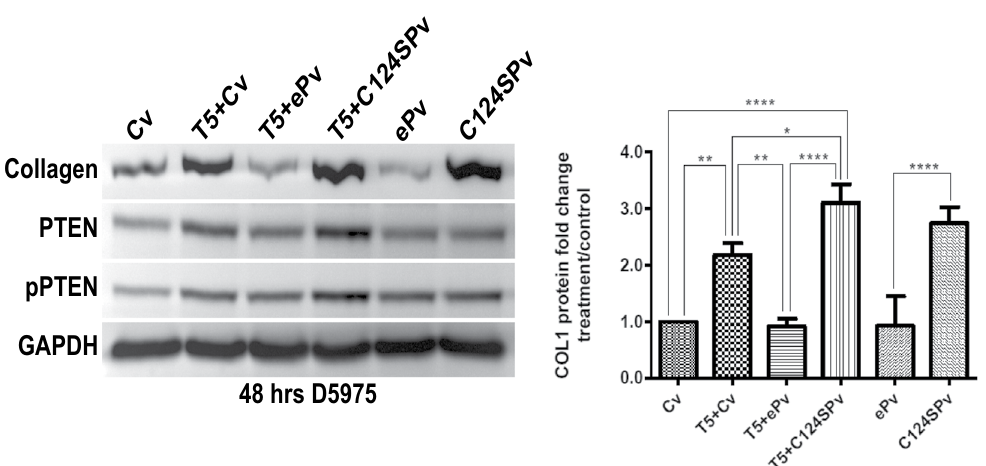
Figure 5. PTEN activity modulates collagen expression in human TM cells. TM cells were treated with TGF- β 2 (5 ng/ml) and transfected with control GFP-vector (Cv), enhanced PTEN-GFP vector (ePv) or C124SPTEN- GFP vector (C124SPv). Enhanced PTEN has eight-fold increased ability to suppress PIP3 signaling, while C124SPTEN has defective lipid phosphatase activity. Densitometry was performed on collagen Western blots using ImageJ software. Statistical significance was determined using one-way ANOVA with Tukey’s post-hoc. * p < 0.05, ** p < 0.01, **** p < 0.0001. N = 3. D5975- representative human donor. Transfection with enhanced PTEN decreased the levels of TGF- β -induced collagen to that of controls, while reducing the levels of PTEN and its phosphorylation. Transfection with C124SPTEN enhanced TGF- β induced increase in collagen levels and this was accompanied by an increase in the levels of PTEN and phosphorylated